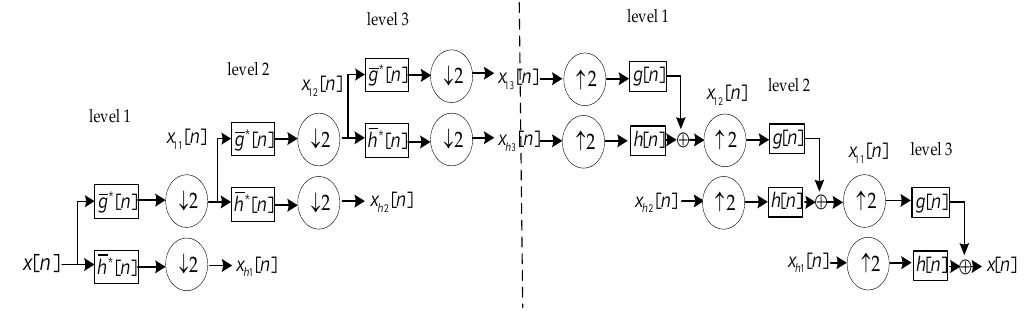
Figure 1. Three-layer wavelet decomposition reconstruction diagram.